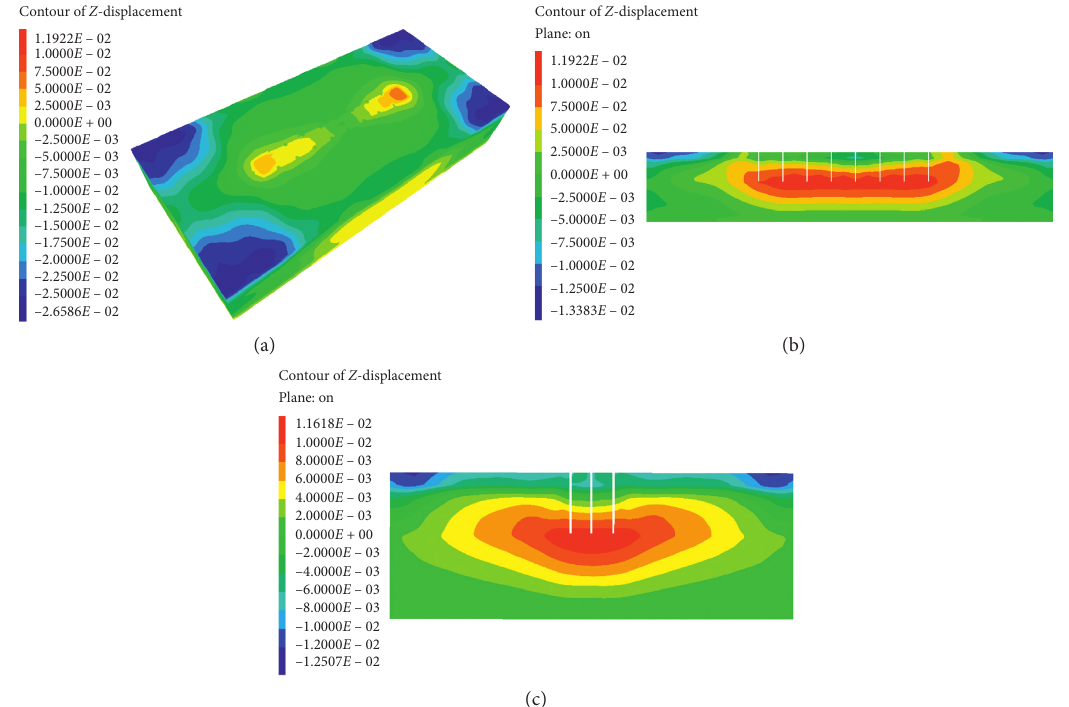
Figure 31: Group wells subsidence nephogram when the drawdown is stable (unit: m). (a) Three-dimensional diagram. (b) Cross section of the well midpoint. (c) Longitudinal section of the well midpoint.